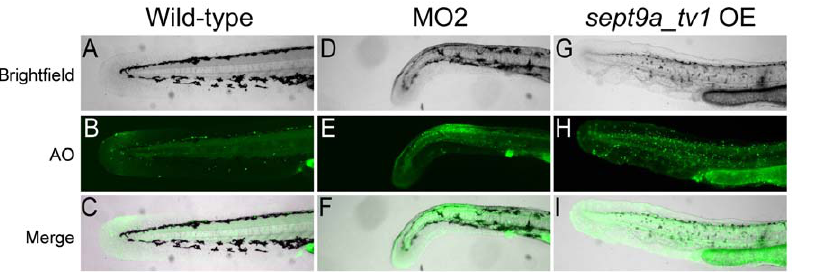
Figure 5. Knockdown and overexpression (OE) of sept9a_tv1 results in an increase in apoptotic cells in the tail. Embryos at the one-cell stage were injected with 2.5 ng of MO2 or 4 pg of sept9a_tv1 mRNA and analyzed for acridine orange (AO) staining at 24 hpf. A–C : The tail fin of wild-type embryos is negative for AO indicating few apoptotic cells. D–I : Both class II MO2 and sept9a_v1 OE embryos show an increase in AO staining indicating increased cell death.